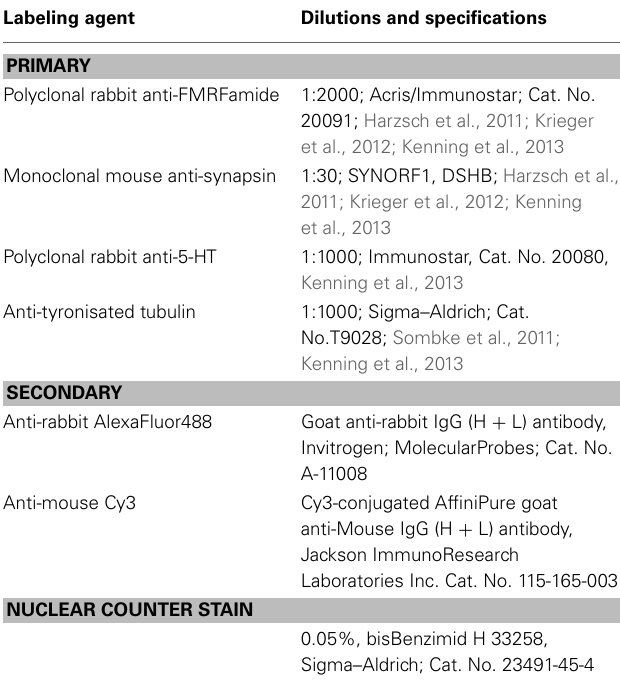
Table 1 | Primary and secondary antibodies used in the study. Labeling